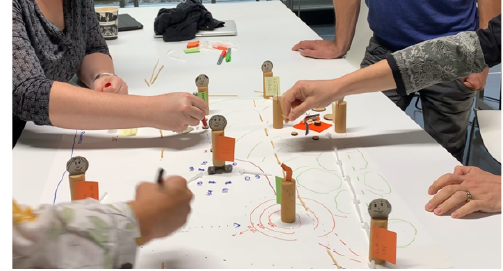
Fig. 1. Activity 1 – Tangible modelling - collaborative and